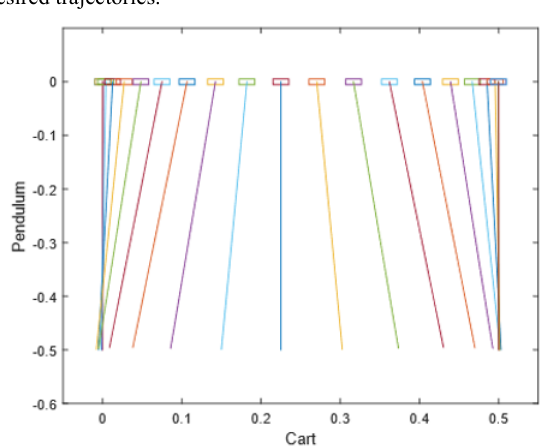
Fig. 3. Transition from the initial state to the terminal